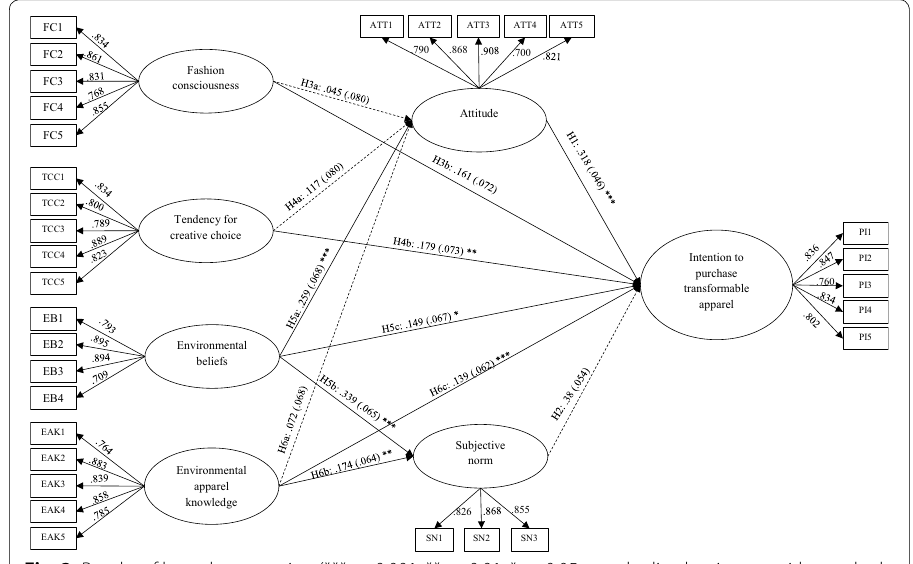
Fig. 2 Results of hypotheses testing (***p < 0.001, **p < 0.01, *p < 0.05; standardized estimates with standard errors in parentheses; the dotted line indicates non-significant